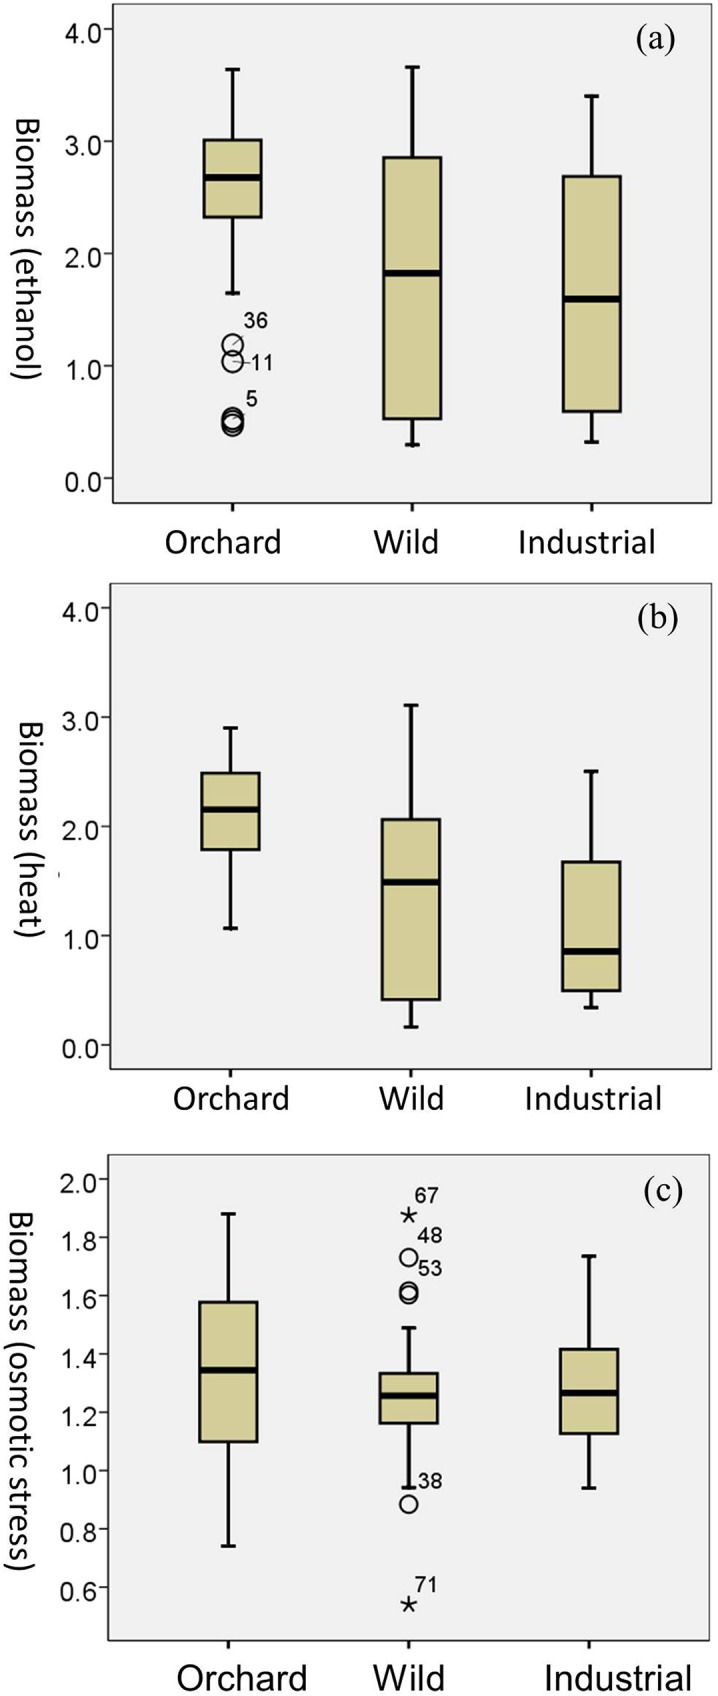
Boxplots depicting stress tolerance variations between the ecological groups.(a) ethanol stress; (b) heat stress; (c) osmotic stress. The number of strains in the Orchard, Wild, and Industrial group was 37, 34, and 12, respectively. The box contains the middle 50% of the data. Horizontal line inside the box: median; Upper boundary of whisker: largest observed value that is not an outlier; Lower boundary of whisker: smallest observed value that is not outlier. ○ = values >1.5 box-lengths from the box but not extremes (outliers). * Values >3 box-lengths from the box (extremes).